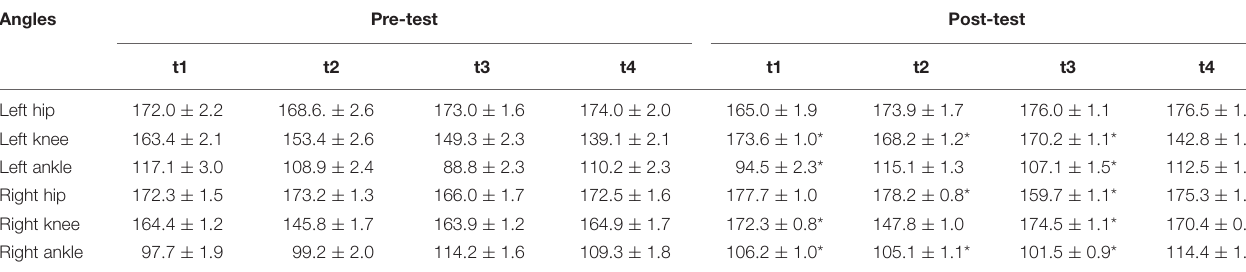
TABLE 5 | Pre-test and post-test of kinematics parameters of the lower extremity (unit: ◦ ).